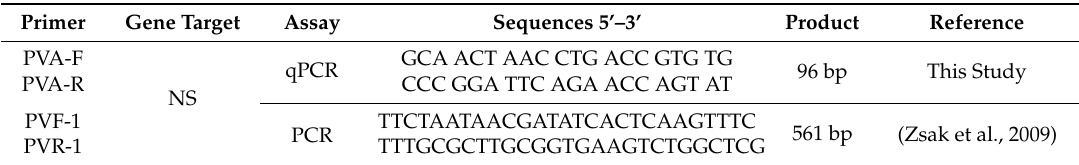
Table 1. Primers used in this